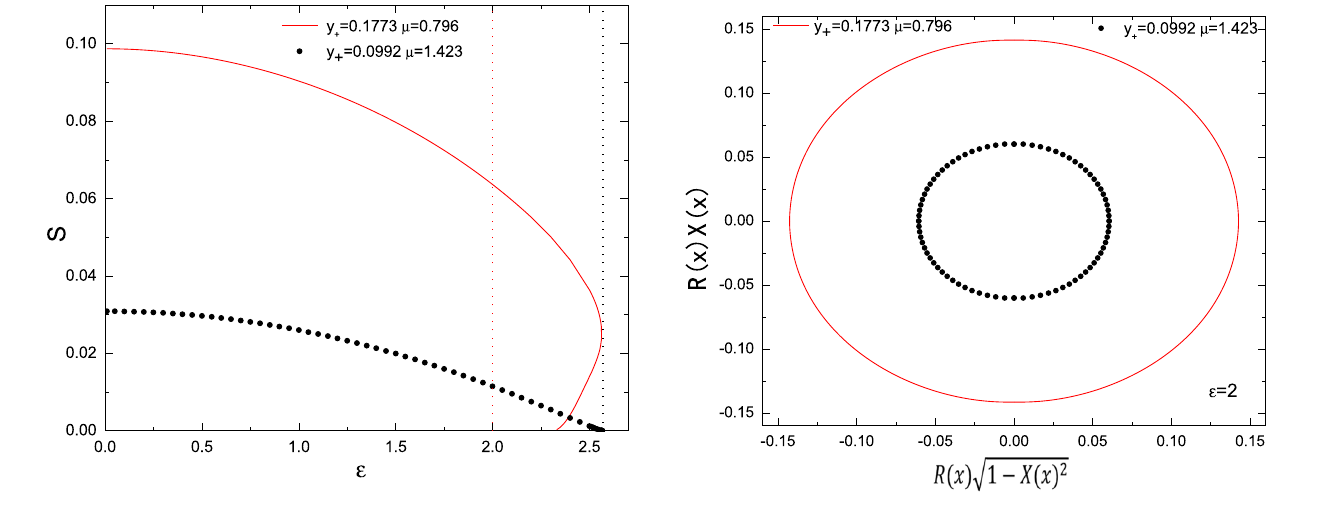
Fig. 10 Numerical results of two small branches for T = 0 . 42 of boundary rotation parameter ε . The vertical red and black dot lines represent ε = 2 and ε = 2 . 57 respectively. Right: hyper- and q = 0 . 07057 when choosing μ = 2 q . The values of μ are y + bolic embedding of the cross section of two small black hole equal to 0 . 796 and 1 . 423 for y + = 0 . 1773 and y + = 1 . 423 respectively. Left: the entropy of two small branches as functions